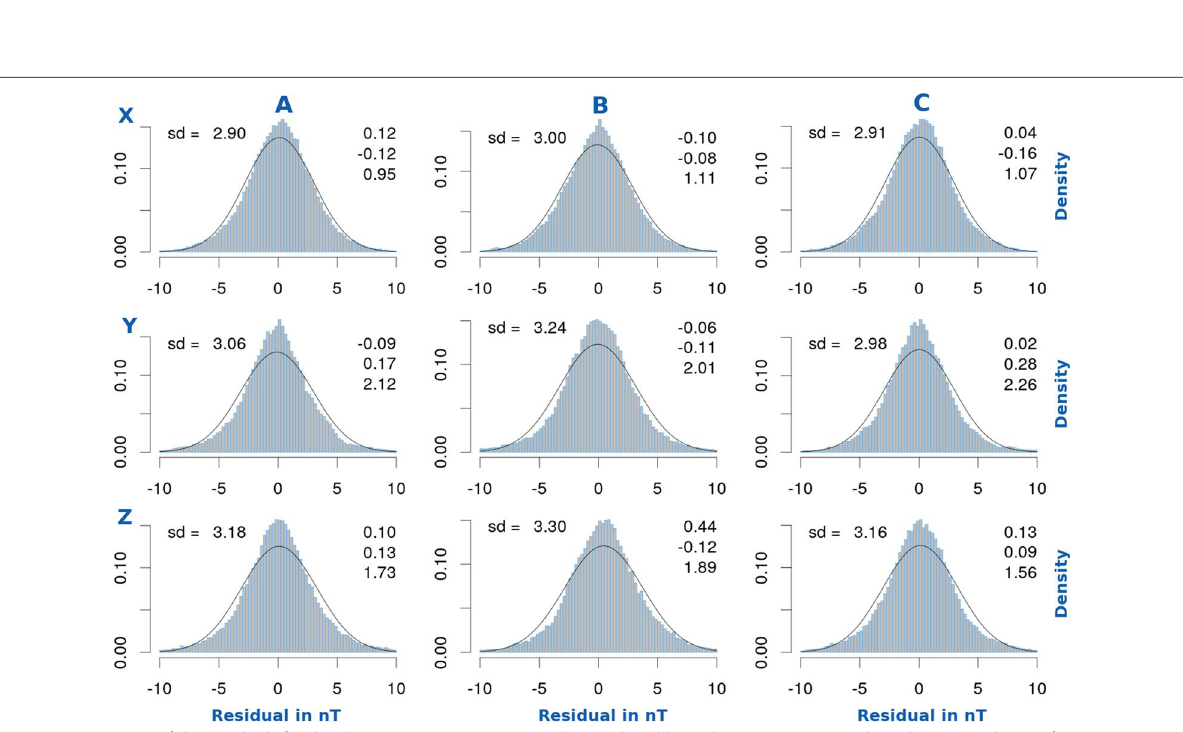
Fig. 3 Geomagnetic power spectra for the main field (MF, in nT 2 ), secular variation (SV, in nT 2 / year 2 ) and secular acceleration (SA, in nT 2 / year 4 ) for 2015.0 for the Mag.num IGRF parent model compared to the CHAOS6-x9 model